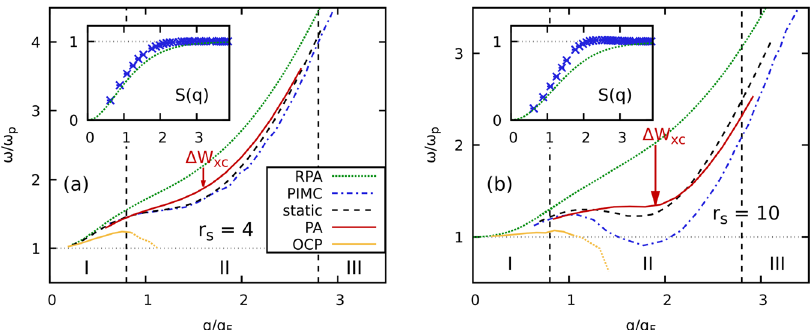
Fig. 4 Electronic pair alignment model for the spectrum of density fl uctuations. Shown is the dispersion ω ( q ) [i.e., position of the maximum in S ( q , ω )] of the warm dense electron gas at the electronic Fermi temperature for a r s = 4 and b r s = 10. Dotted green: random phase approximation (RPA); dash-dotted blue: exact path integral Monte Carlo (PIMC) results 20 using the full G ( q , ω ); dashed black: static approximation, i.e., setting G static ( q , ω ) = G ( q , 0); solid yellow: classical one-component plasma (OCP) at Γ = 1.92 ( r s = 4) and at Γ = 4.8 ( r s = 10); solid red: electronic pair alignment model [Eq. (1)] introduced in this work; the red arrows indicate the corresponding average red-shift compared to RPA. We can distinguish 3 distinct physical regimes: (I) λ ≫ d [collective], (II) λ ~ d [electronic pair alignment, two-particle excitations], and (III) λ ≪ d [single-particle]. The insets show PIMC and RPA results for the static structure factor S ( q ) and illustrate the absence of spatial structure at